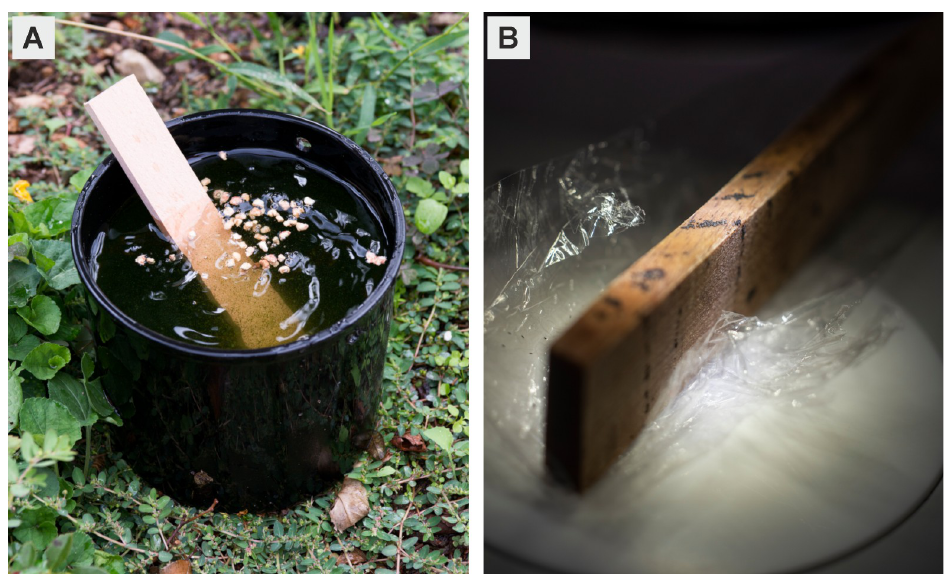
Fig 1. Ovitrap used to collect eggs of invasive Aedes species. (A) The female mosquitoes glue their eggs on the slat that is plunged into the water inside the flower pot. The slats were collected and inspected biweekly. Photo credit: Roland Schmid, Swiss TPH. (B) Slat with Aedes mosquito eggs. Photo credit: Christian Flierl, University of